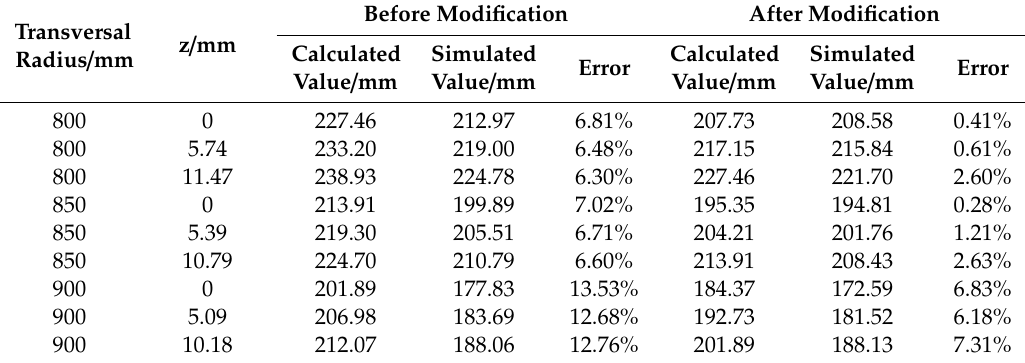
Table 3. Error comparison of longitudinal curvature radius for saddle